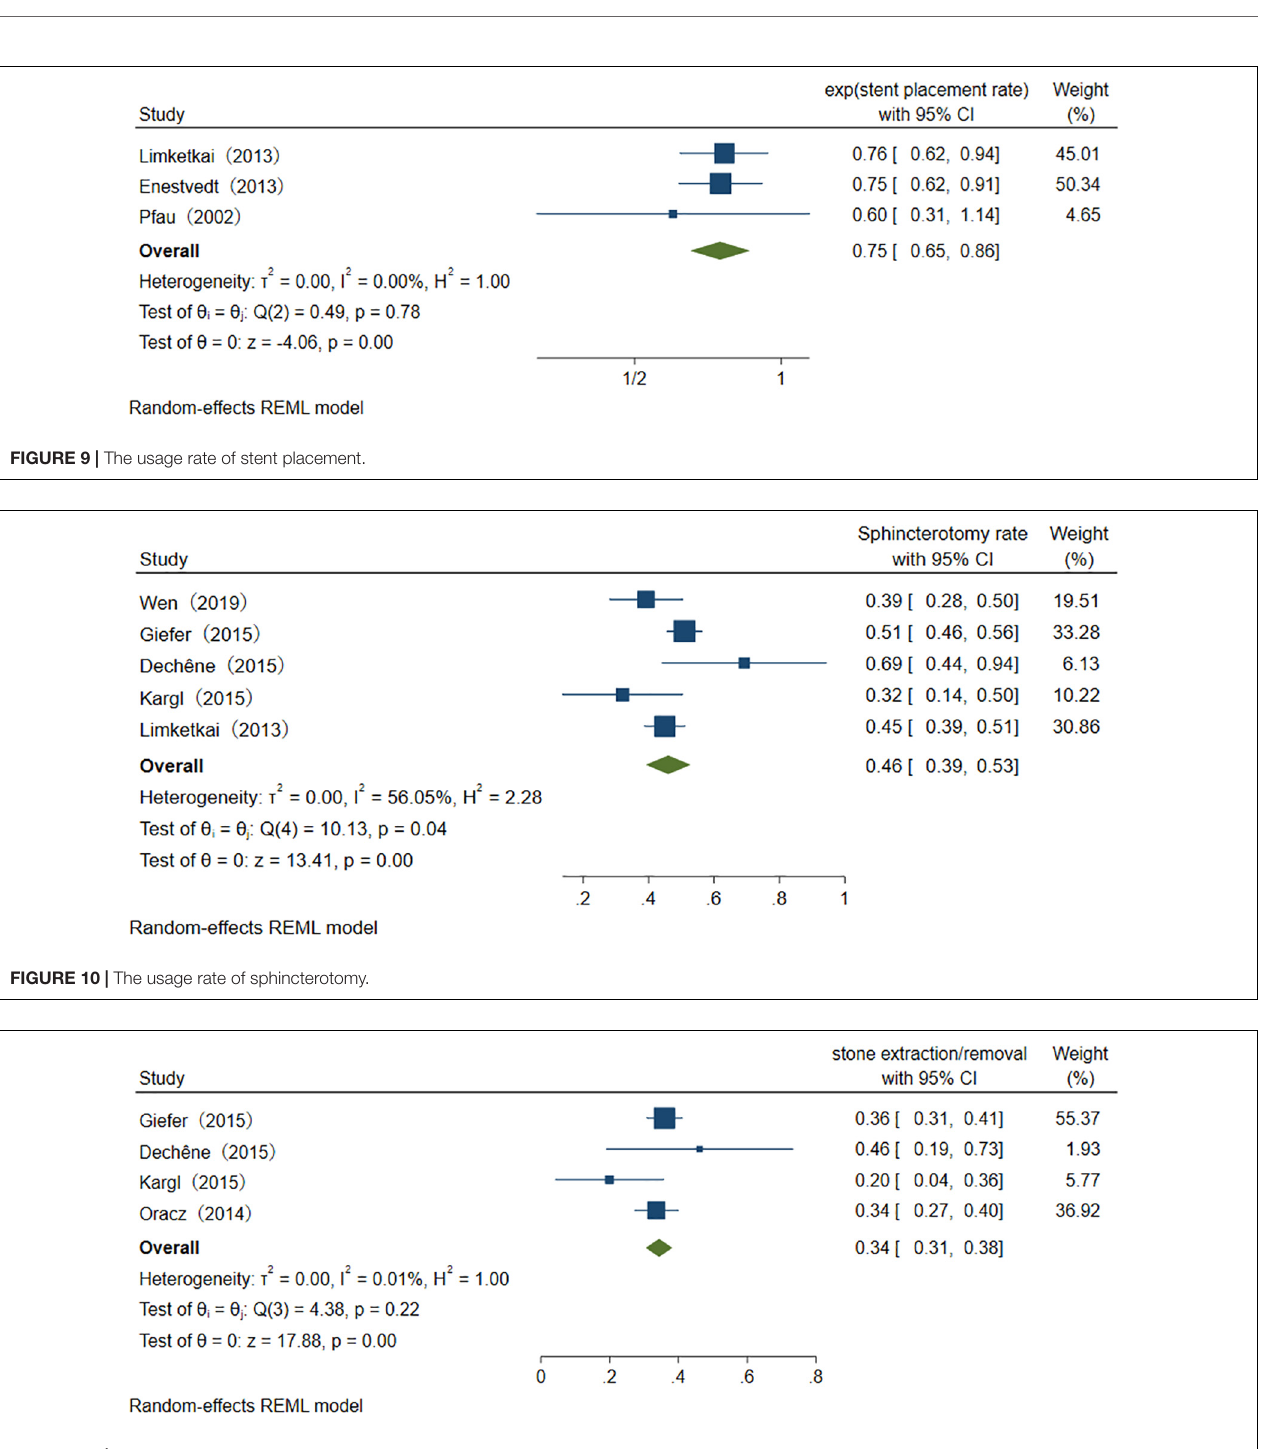
obstruction, significant stenosis of the pancreatic duct, etc.), and specific primary diseases (choledocholithiasis, acute gallstone pancreatitis, chronic idiopathic pancreatitis, biliary atresia, etc.) ( Table 5 ). Pre-operative ERCP before surgery may benefit patients with HPB, it can serve as a transitional step to